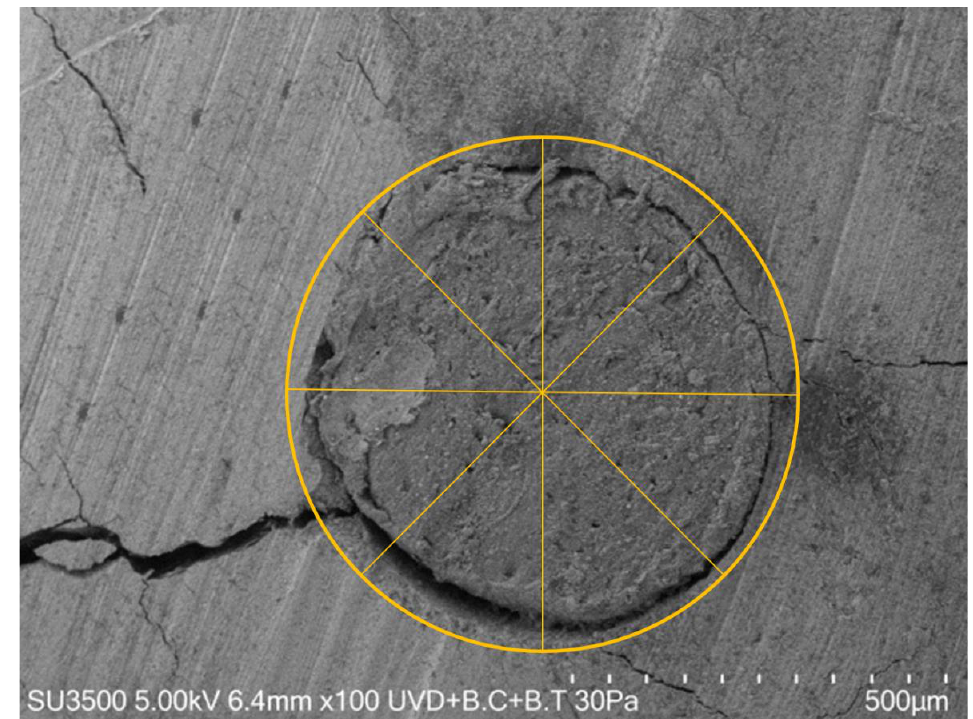
Figure 1. SEM micrograph showing the measurement methodology. Each transverse section was divided into 8 slices and the major value in terms of the marginal gap of each slice was recorded using ImageJ software. The overall maximum gap value for each specimen resulted from calculating the average of all 8 slice values